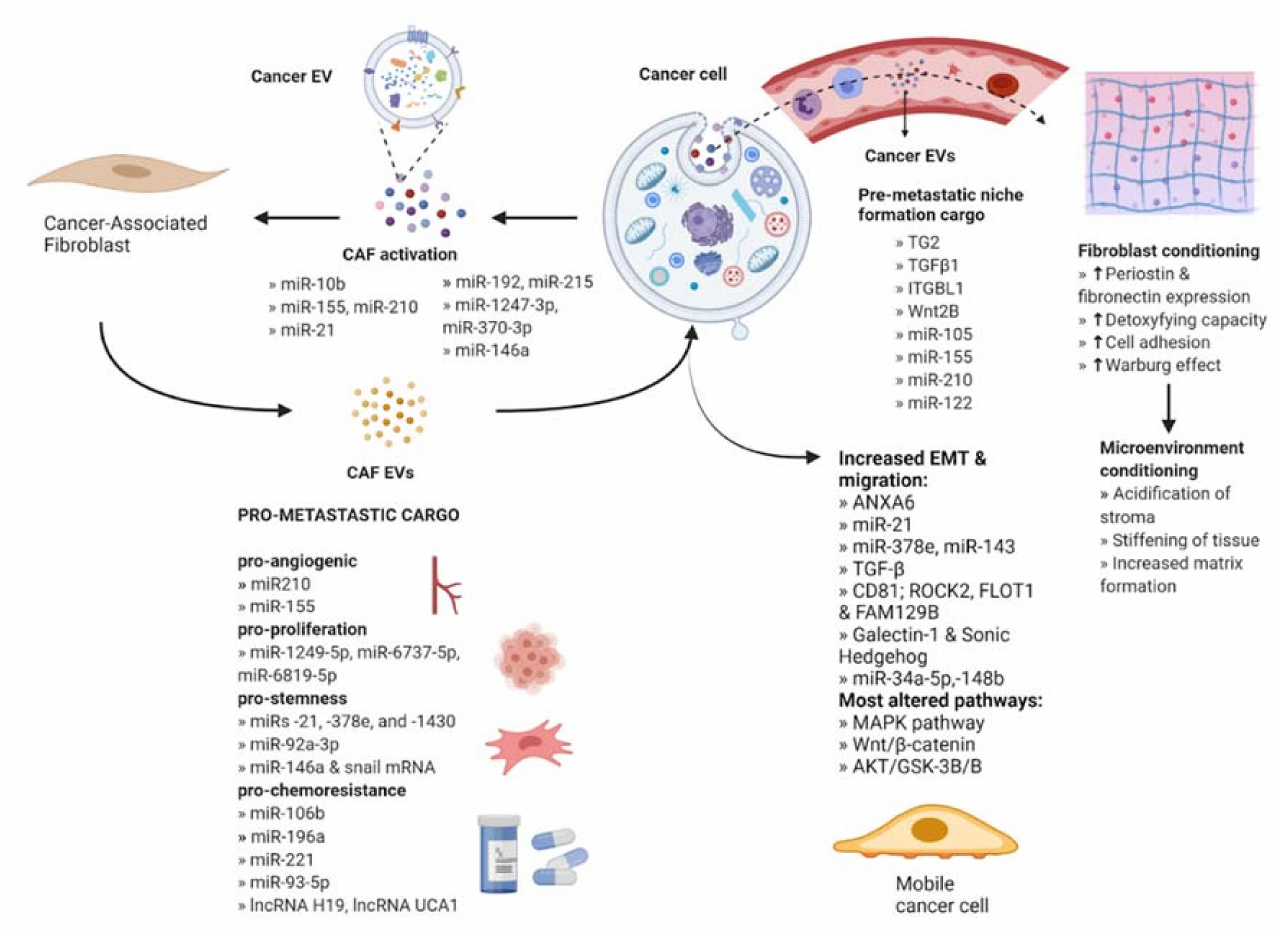
Figure 2. Intercellular communication between cancer cells and stromal fibroblasts. Cancer-derived EVs act on fibroblasts to facilitate activation into cancer associated fibroblasts (CAFs). CAF EVs act on cancer cells to enhance their metastatic potential by delivering bioactive molecules. The released cargo modifies several key signaling pathways that promote angiogenesis, proliferation, stemness, chemoresistance, and EMT. Cancer EVs also act at a secondary site via the bloodstream through activation of local fibroblasts to CAFs which condition the microenvironment for the establishment of the pre- metastatic